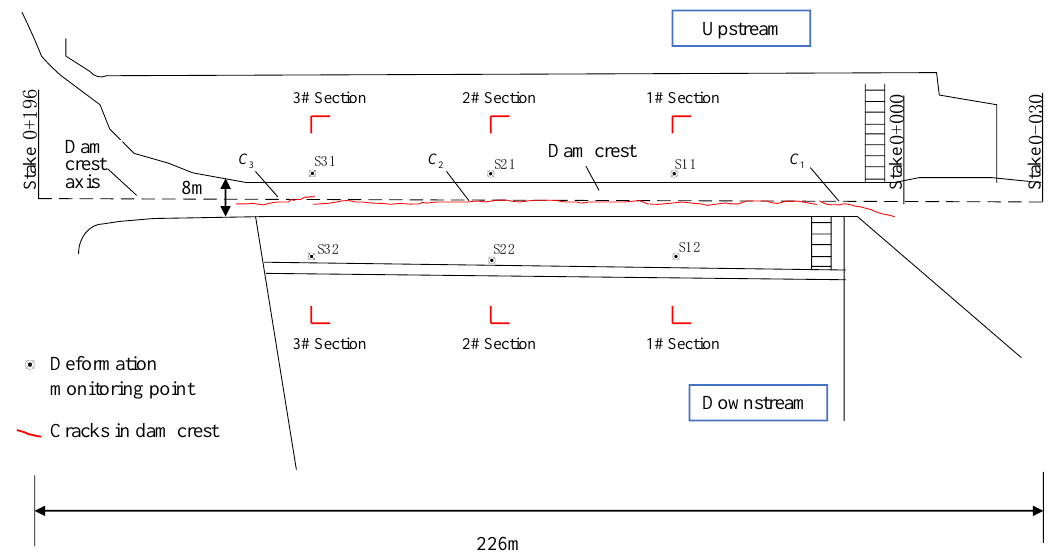
Figure 6. Layout diagram of deformation measurement points of Wujing dam.